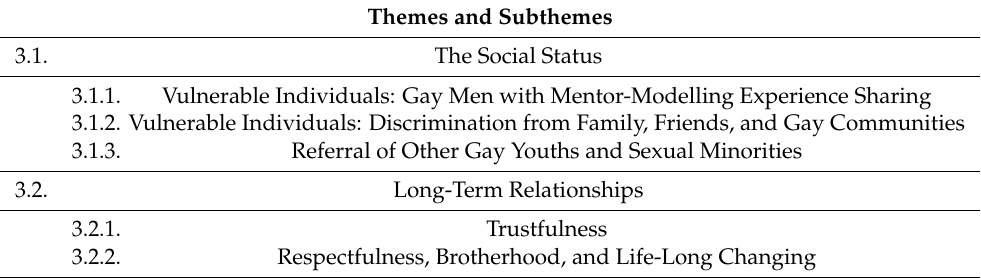
Table 1. Themes and